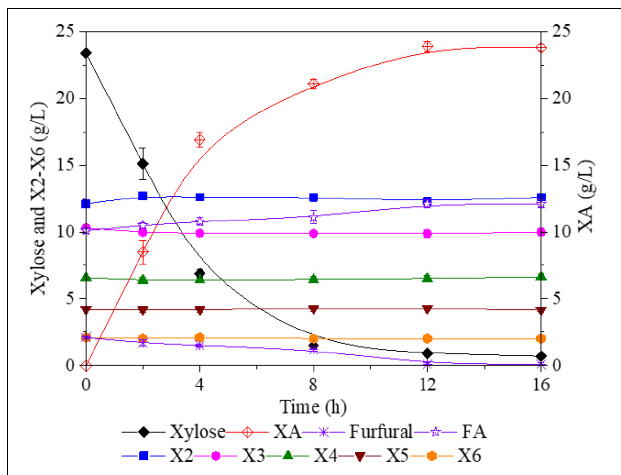
FIGURE 4 | Bioconversion of xylose and furfural into XA and FA by Gluconobacter oxydans . XA, xylonic acid; FA, furoic acid.